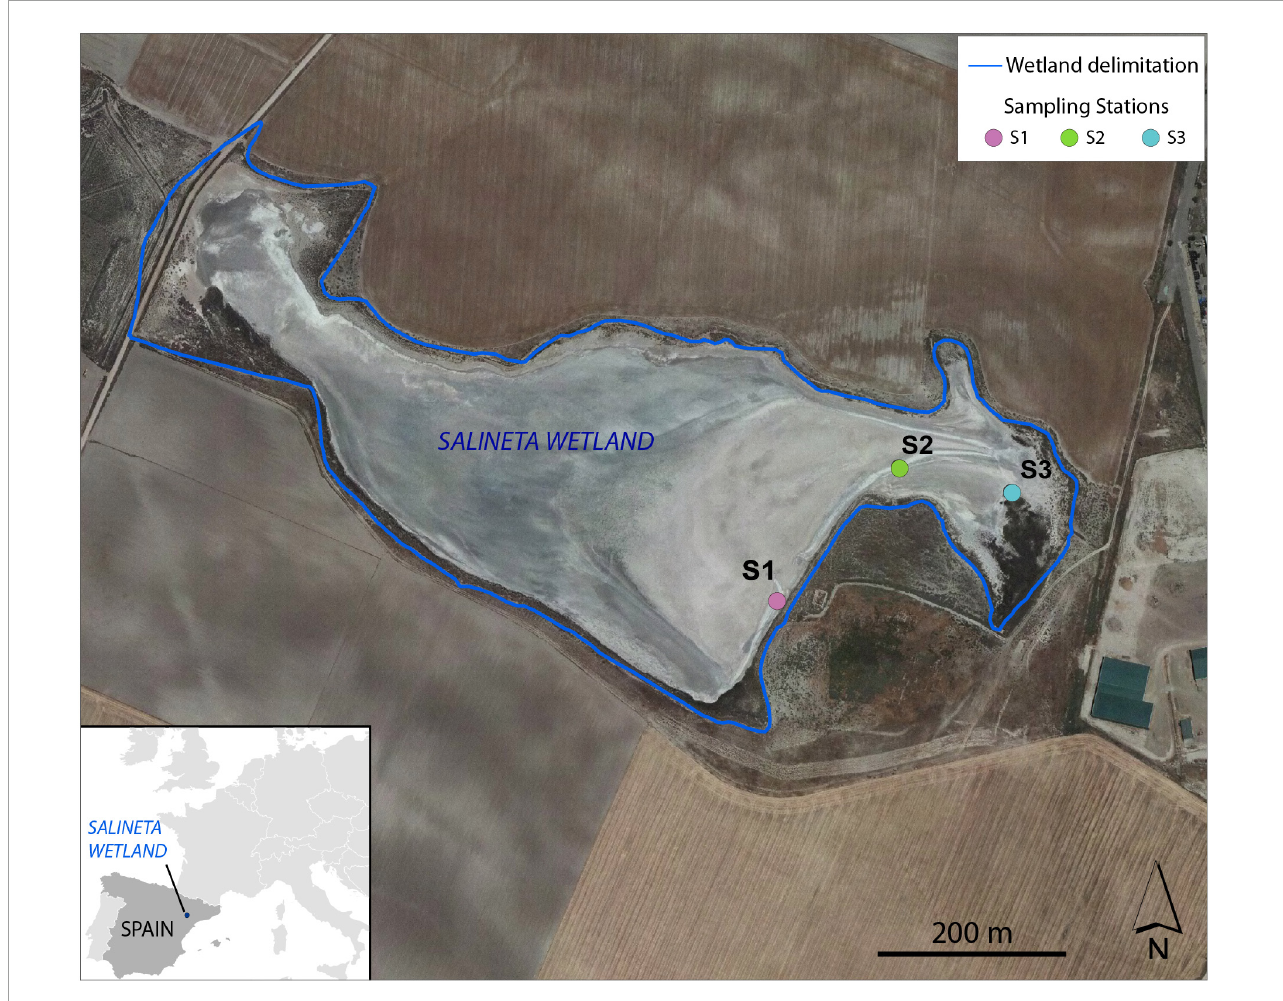
FIGURE1 Location of the sampling stations (S1, S2, and S3) at Salineta wetland in the orthophotograph of PNOA 2015 (National Geographic Institute of